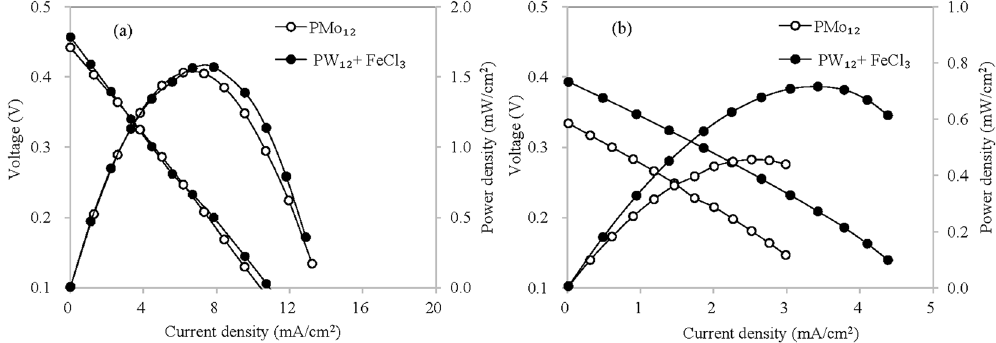
Figure 4. Performance of the LCFC using FeCl 3 and PW 12 as the catalyst when dealing with starch and cellulose ( a ) 40 g/L starch; ( b ) 40 g/L cellulose; PMo 12 , PW 12 , FeCl 3 and phosphoric acid are 0.30, 0.06, 1.00 and 1.5 mol/L, respectively).